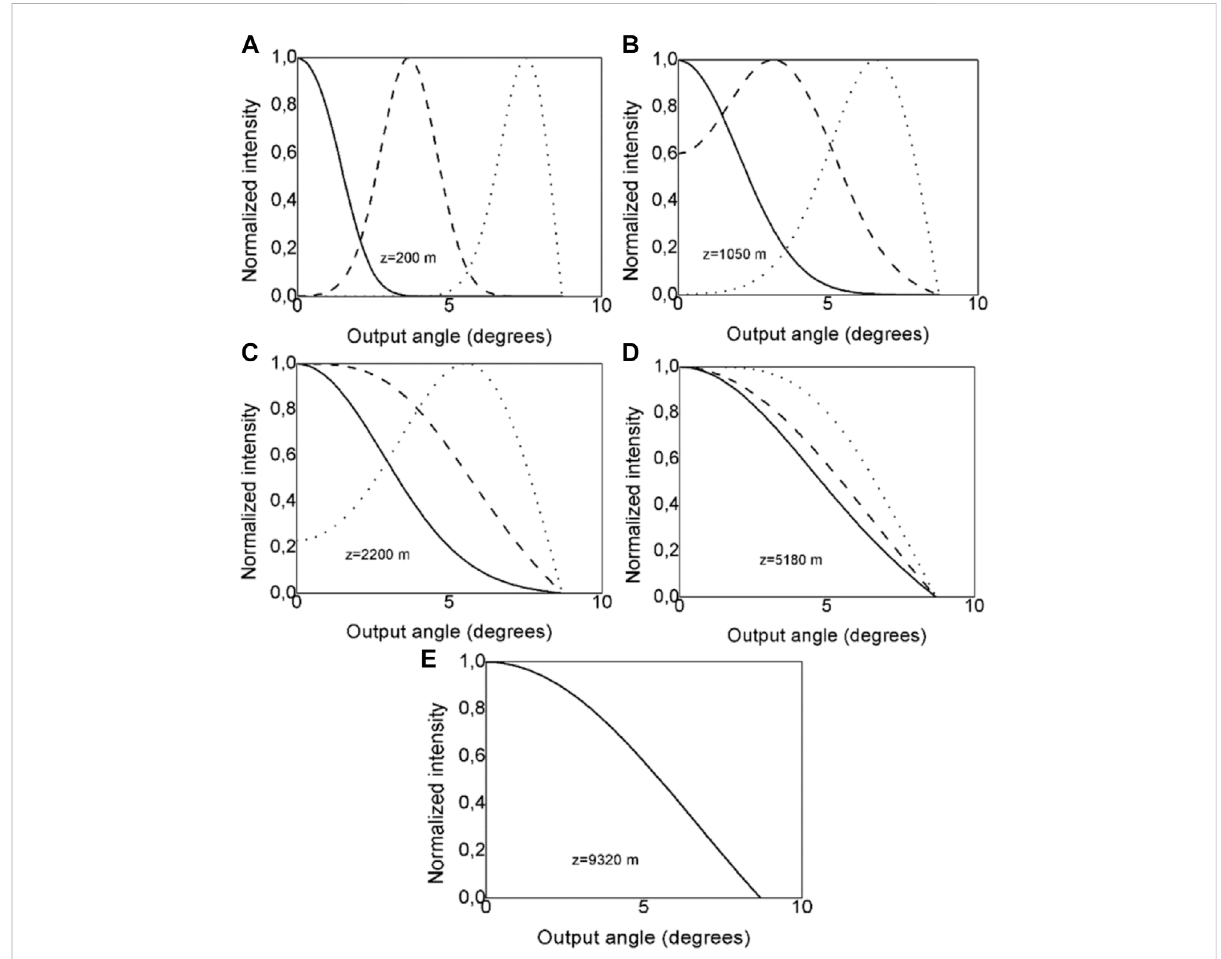
FIGURE 2 Normalized output angular power distributions of different locations along each carrier seven cores of the MM MC SOF, for different Gaussian inputangles θ 0 =0(solidline),4(dashedline)and8 o (dottedline),with(FWHM) z =0 =1for: (A) z =200 m; (B) z =1,050 m; (C) z =2,200 m; (D) z = L c = 5,180 m and (E) z = z s = 9,320 m (The solid line, dashed line and dotted line are overlapped at fi ber length z s at which SSD is